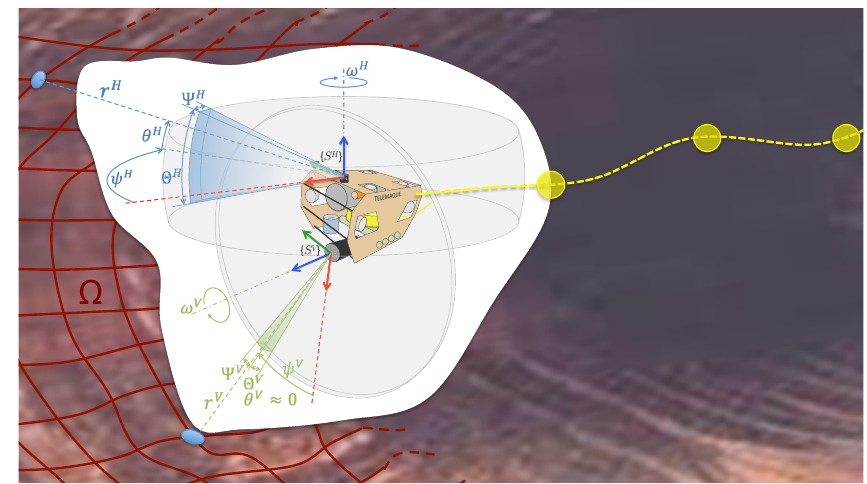
Figure 3. The vertical and horizontal profiling sonars mounted on Telemaque while scanning the environment’s surface Ω .